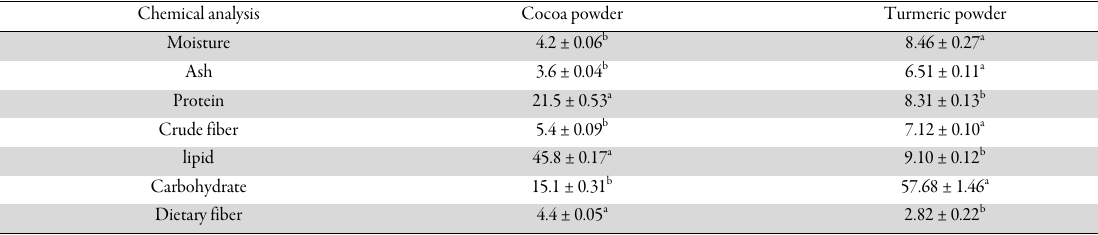
Table 3. Chemical composition of raw flour Chemical Composition